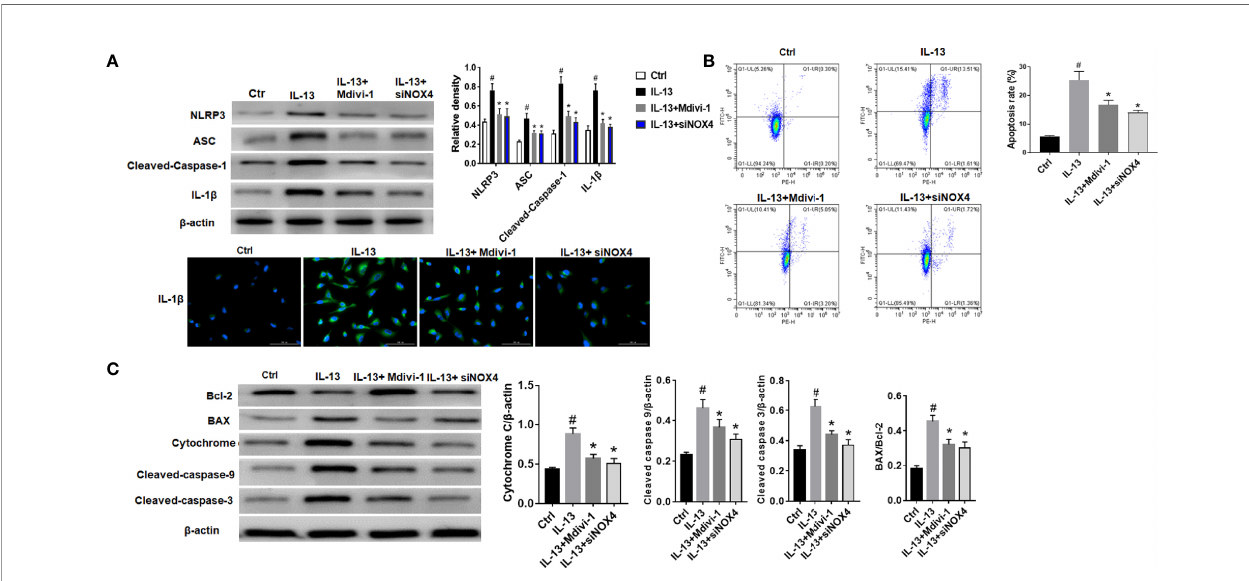
FIGURE 3 | NOX4 and Drp1 are involved in epithelial cell apoptosis and NLRP3 activation. (A) Western blot of NLRP3, ASC, Cleaved-caspase-1 and IL-1 b . Intervention was performed with siNOX4 and Mdivi-1, respectively, before IL-13 stimulation. IL-1 b protein cyto fl uorogram. Green fl uorescence represents IL-1 b and blue fl uorescence represents nucleus. Scale bar: 100 µm; (B) BEAS-2B cells were stimulated with IL-13. siNOX4 and Mdivi-1 were intervened in advance. Different apoptotic ratios were determined by fl ow cytometry analysis. (C) The expression of BAX, Bcl-1, cytochrome c, and Capsese-9/-3 was analyzed by Western blot. All data were shown as mean ± SD (n = 3). # p < 0.05 versus control, * p < 0.05 versus IL-13 group as determined by one-way analysis of variance (ANOVA) and Dunnett ’ s post hoc